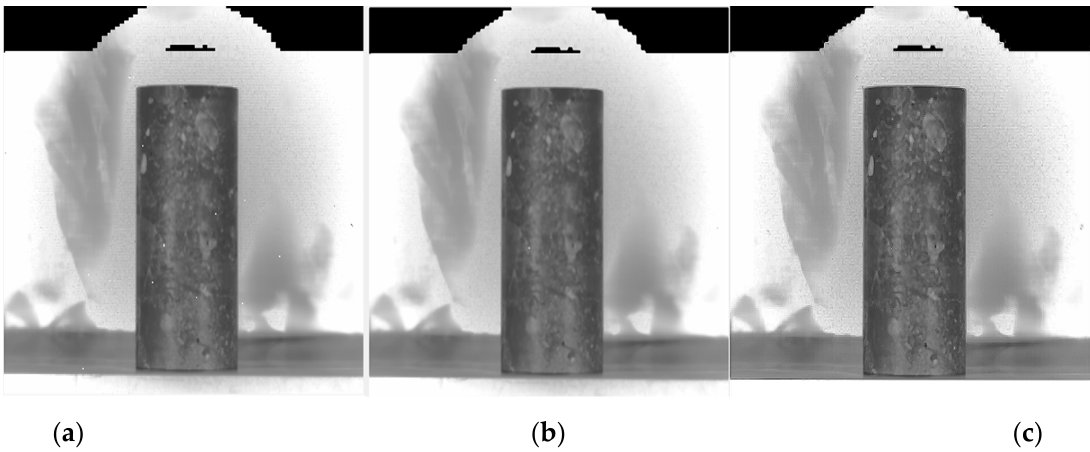
Figure 3. Concrete IR image pre ‐ processing results: ( a ) image quality evaluation; ( b ) image noise removal; ( c ) image sharpening.